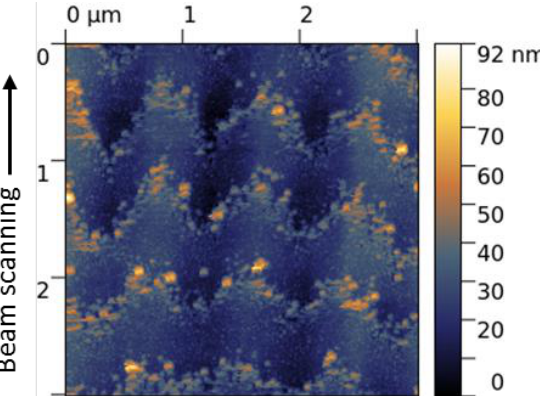
Figure 5. AFM image of a central region in the microgroove produced on the DLN film at F = 0.32 J/cm 2 and v s = 0.08 m/s and shown in Figure 1b; AFM tip scanning was made across the groove perpendicularly to the laser beam scanning direction.